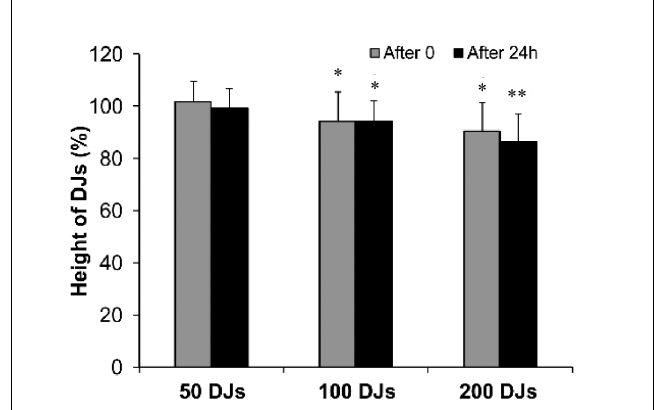
Figure 2. Height of drop jumps (DJs) changes after 50, 100 and 200